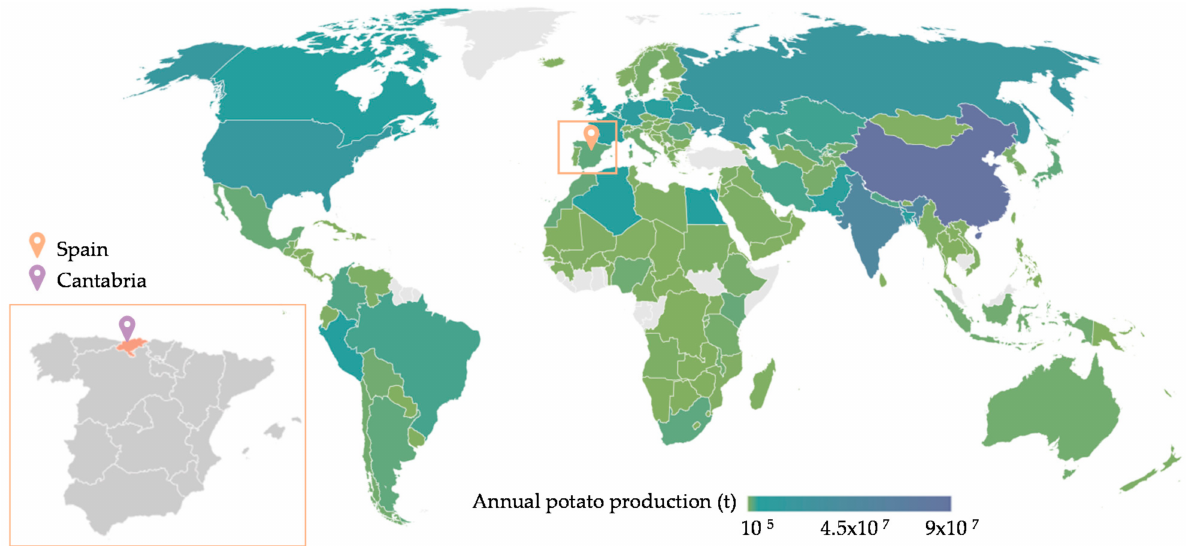
Figure 1. Distribution of potato production worldwide. Data collected from FAOSTAT